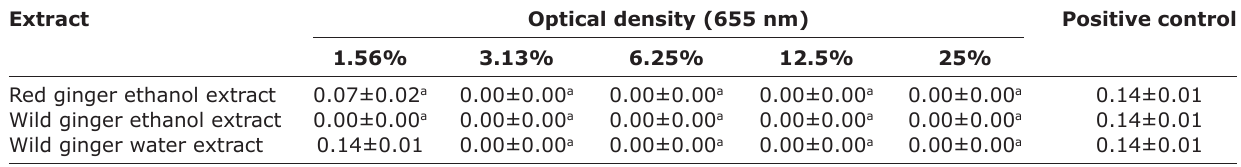
Table-2: Growth of Salmonella Enteritidis in media enriched with herbal extracts.